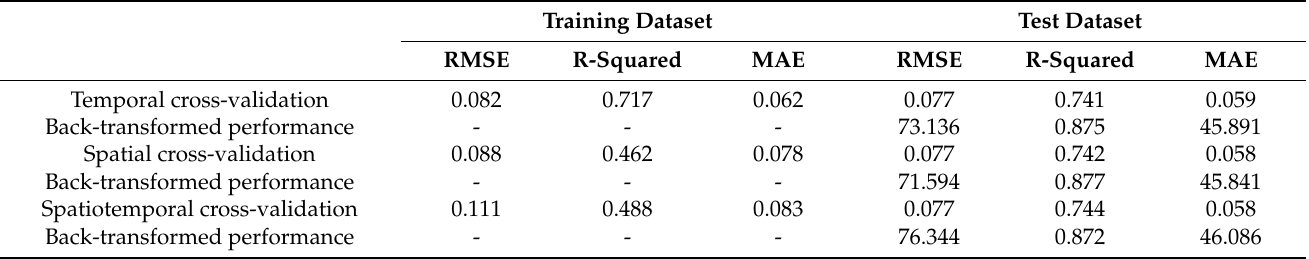
Table 3. Comparison of the random forest (RF) model performance in the training and test datasets using temporal, spatial and spatiotemporal cross-validation